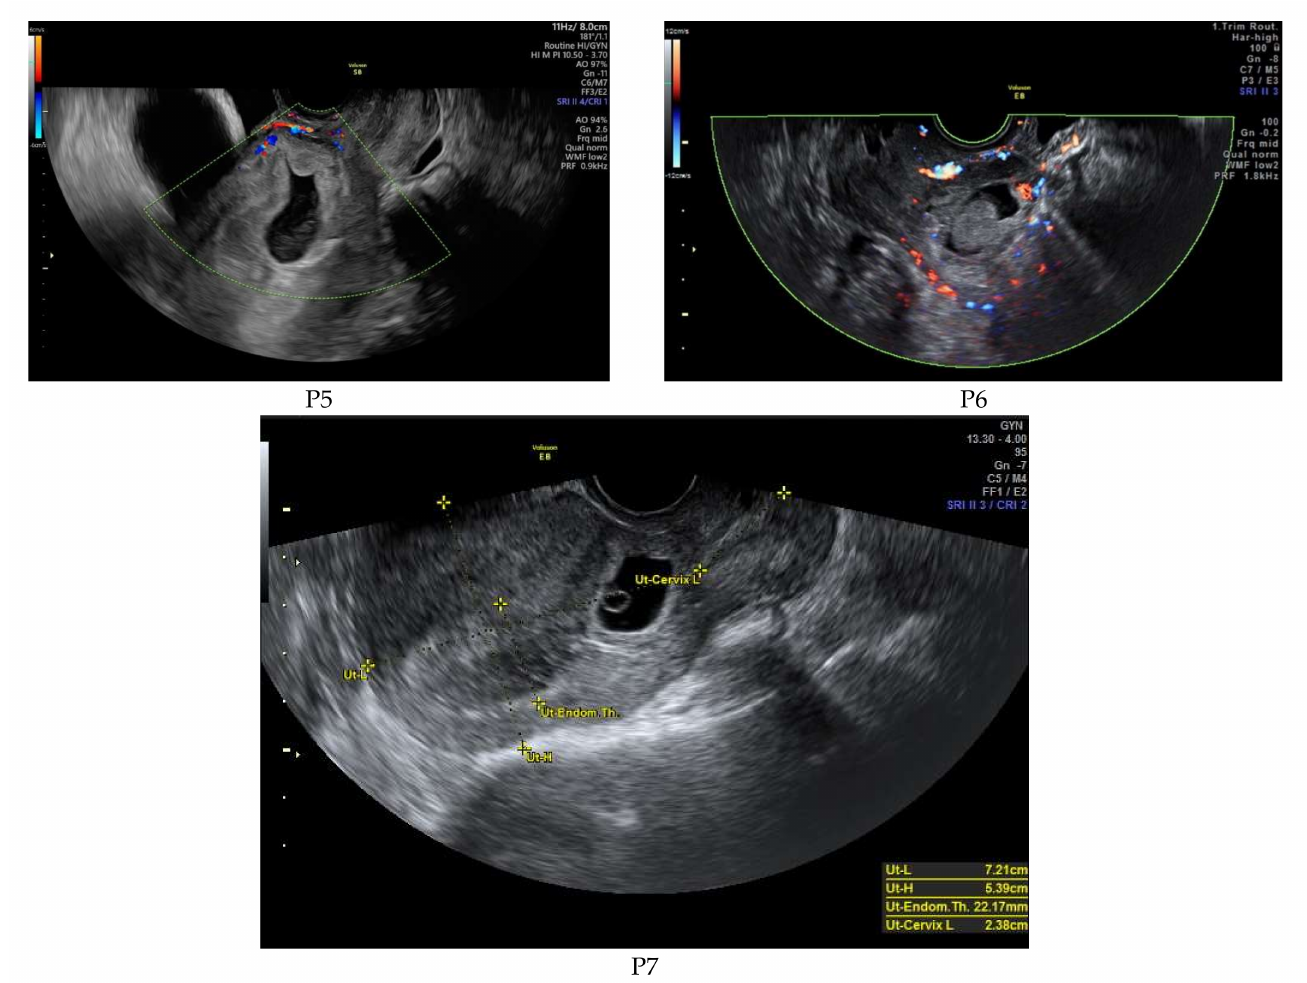
Figure 1. CSP ultrasound imaging for the cases presented in this study before treatment.